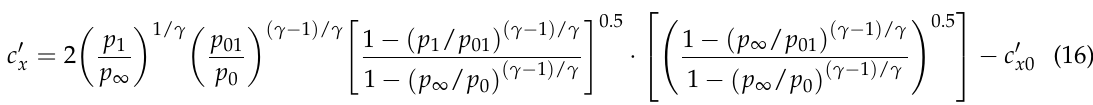
Figure 6. The profile and the distribution of the pressure taps for the test LUT airfoil. The total number of pressure taps is 50 on the surface of the airfoil, and the density of the pressure taps is closely distributed at the leading edge and the trailing edge of the test LUT